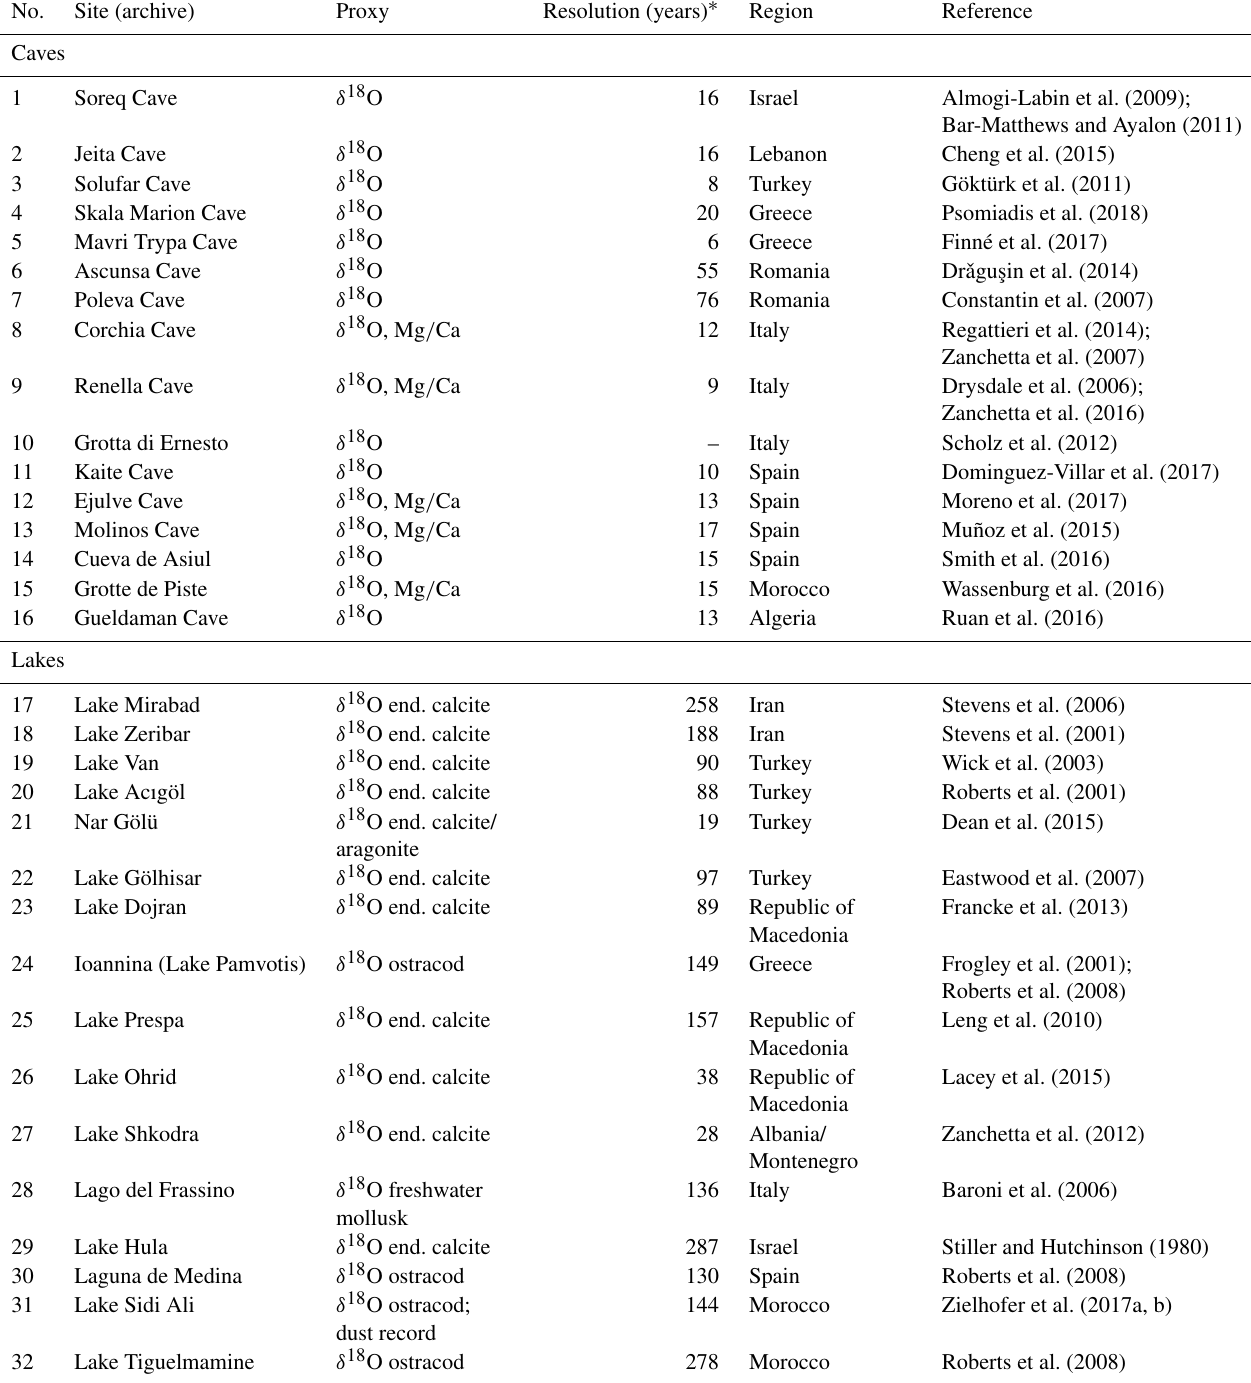
Table 1. Sites and proxy records selected in this paper for investigating the 4.2kaBP Event. Resolution is reported only for selected proxies and is intended as the average during the